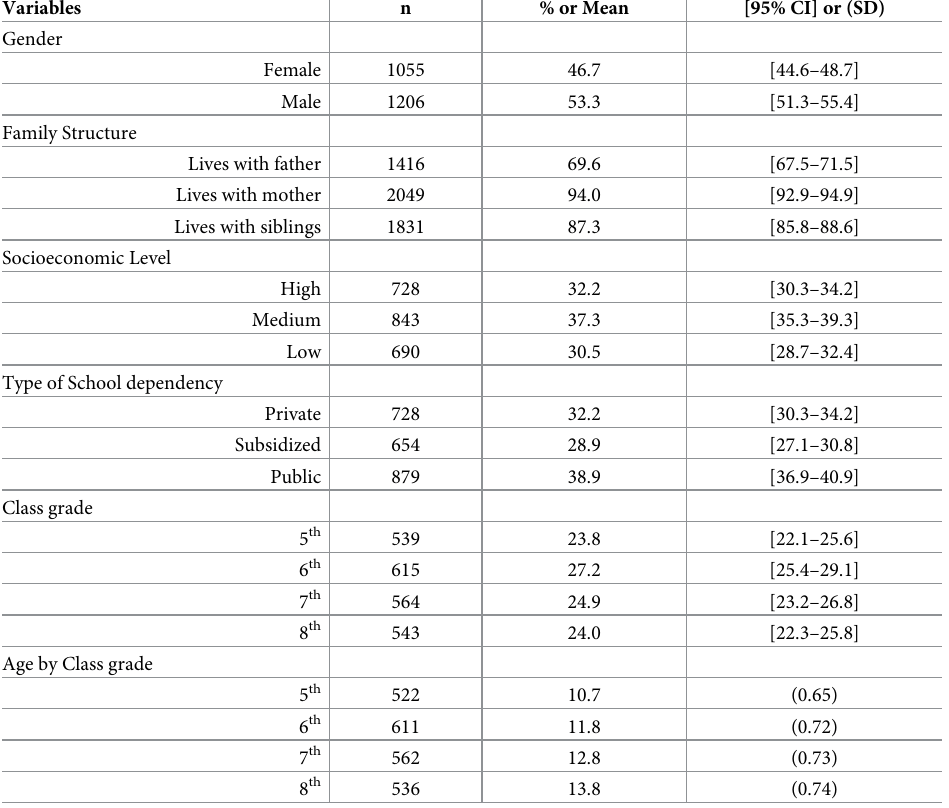
Table 1. Sociodemographic